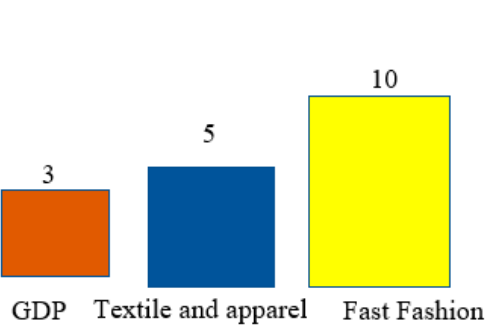
Figure 4. Comparison of the average growth rate of global GDP, total textile and apparel, and fast fashion (2011–2015).—% p.a. Source: Authors’ elaboration based on